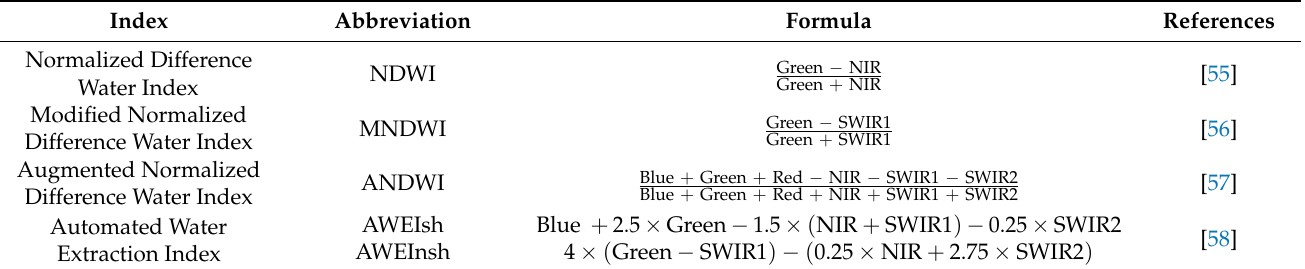
Table 2. Spectral water indices used for imaging water feature